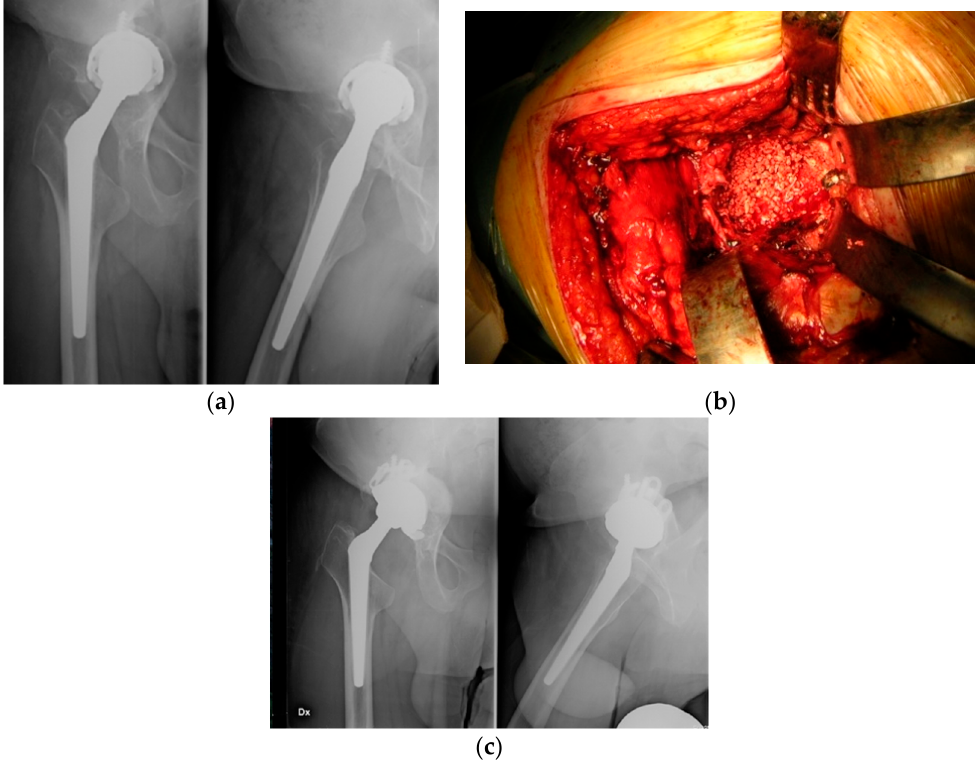
Figure 1. Clinic case: 76 y female with loosening of the acetabular cup ( a ) Pre-operative x-rays, ( b ) Intraoperative pictures show the acetabulum impacted with Engipore chips filling the bone defect (Paprosky 3a), ( c ) Post-operative x-rays at the last follow-up (3.2 years) showing good osteointegration of the implant.